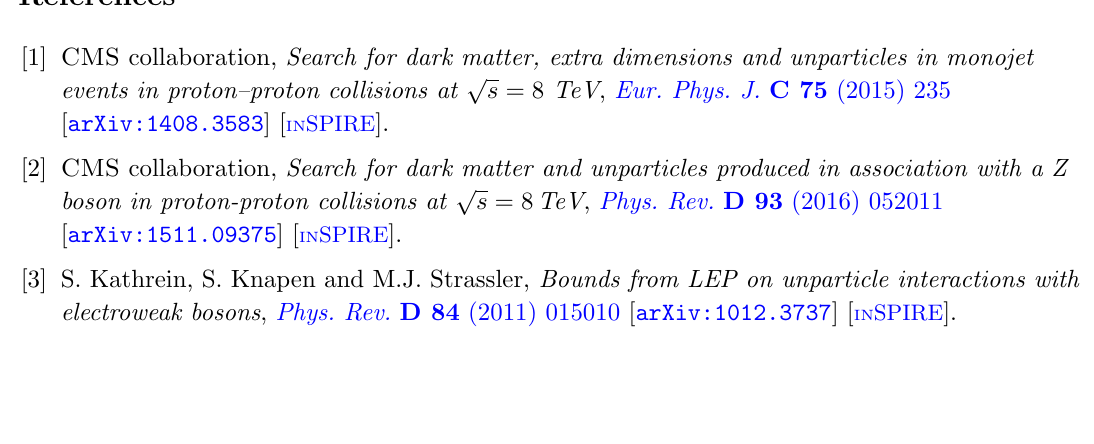
p s = 8 and 13 TeV.